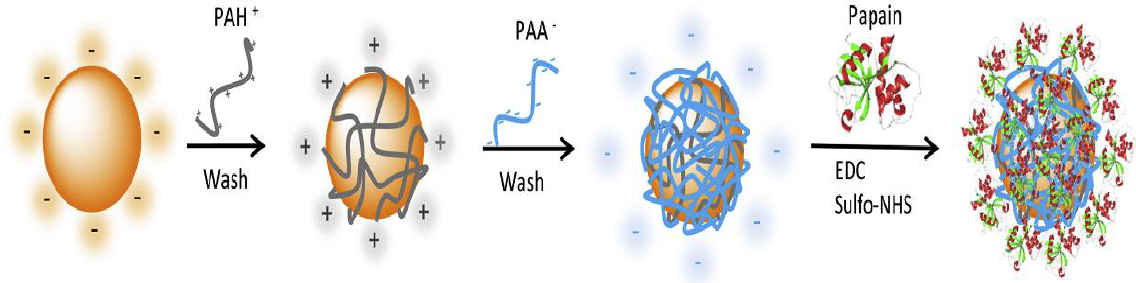
Figure 7. Schematic representation of the functionalization process of AuNPs with papain. The surface modification was achieved by a layer-by-layer (LbL) approach via activation of COOH groups of the modified AuNPs with EDC and sulfonated NHS as coupling agents, followed by amide bonding with the NH 2 groups of papain. (PAH+, polyallylamine hydrochloride; PAA − , polyacrylic acid sodium). Adapted from ref. [68], copyright 2017, with permission from Elsevier.